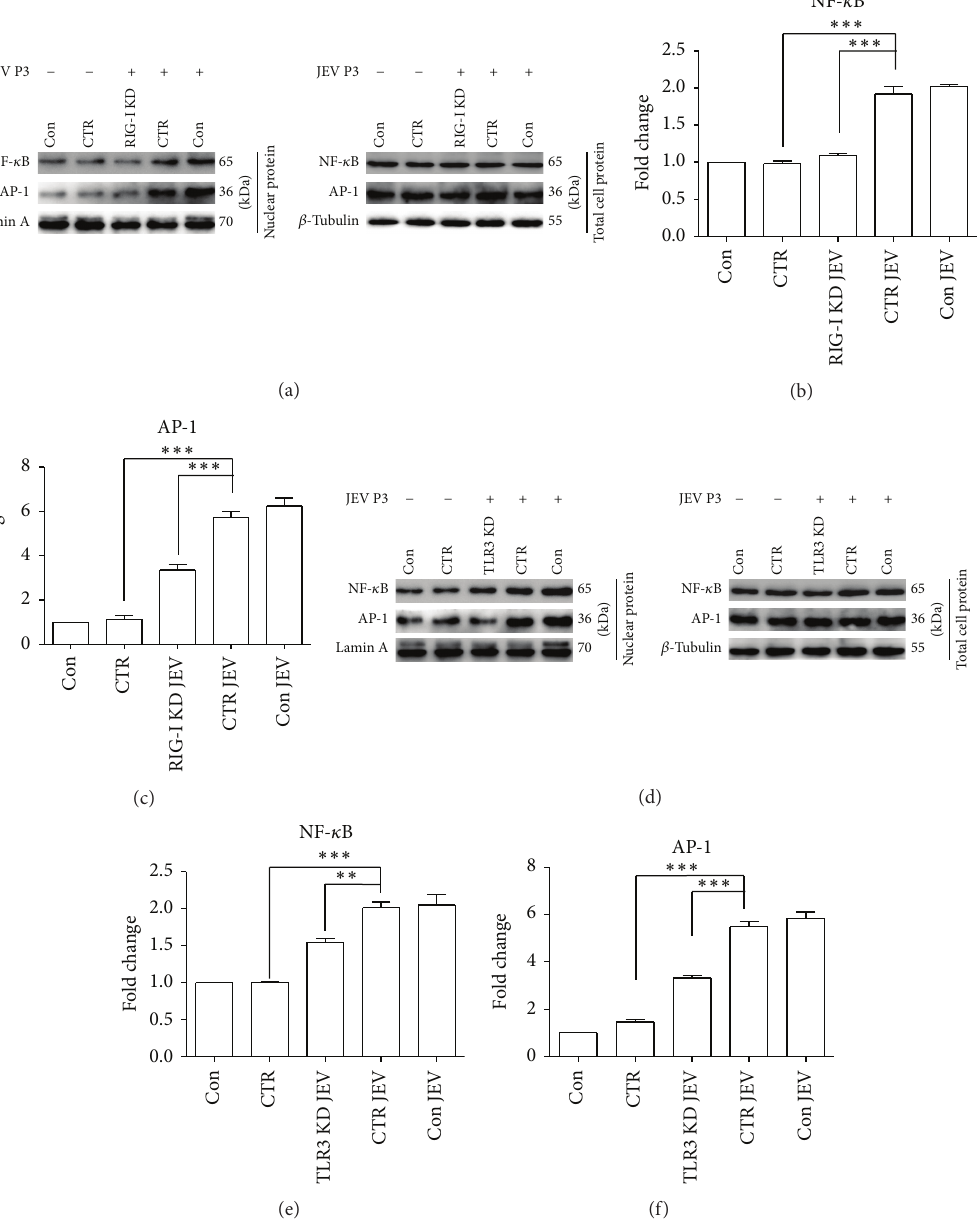
Figure 7: Knockdown of RIG-I and TLR3 reduces the nuclear translocation of AP-1 and NF- 𝜅 B. (a) BV-2 cells were transfected with RIG- I shRNA (RIG-I KD) or negative control shRNA (CTR) and then infected with JEV at an MOI of 1. AP-1 and NF- 𝜅 B in the nucleus were detected with western blotting at 5 hpi. (d) BV-2 cells were transfected with TLR3 shRNA (TLR3 KD) or negative control shRNA (CTR) and then infected with JEV at an MOI of 1. AP-1 and NF- 𝜅 B in the nucleus were detected with western blotting at 5 hpi. (b, c, e, f) The protein levels were quantified with immunoblot scanning and normalized to the amount of lamin A or 𝛽 -tubulin. Error bars represent the standard deviation of results from three independent assays ( ∗∗ 𝑃 < 0.01 ; ∗∗∗ 𝑃 < 0.001